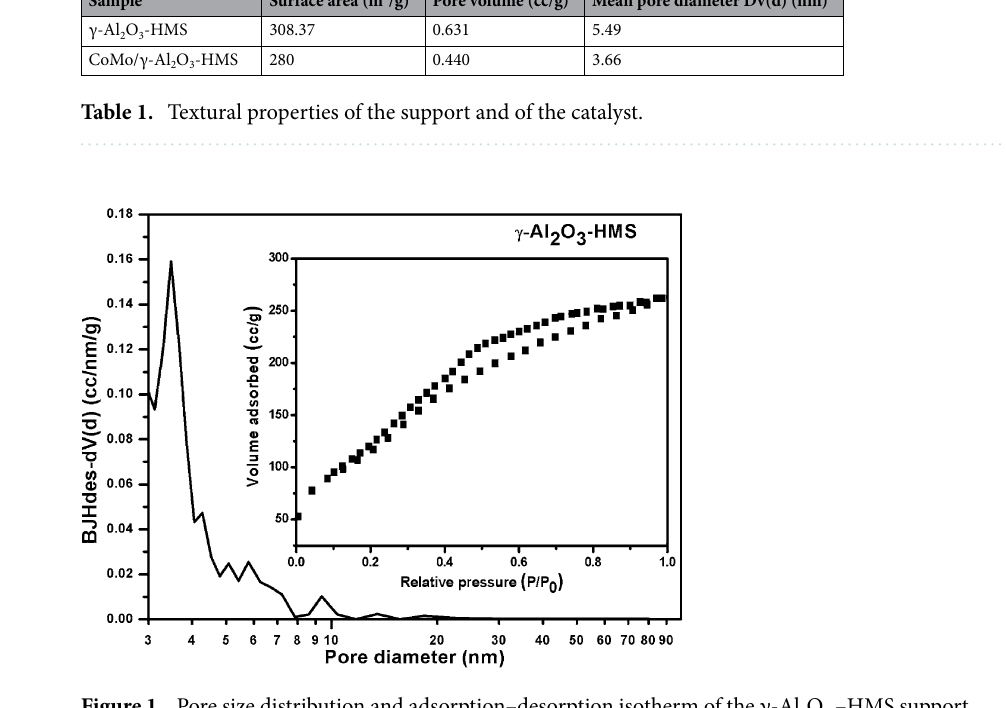
Figure 1. Pore size distribution and adsorption–desorption isotherm of the γ-Al 2 O 3 –HMS